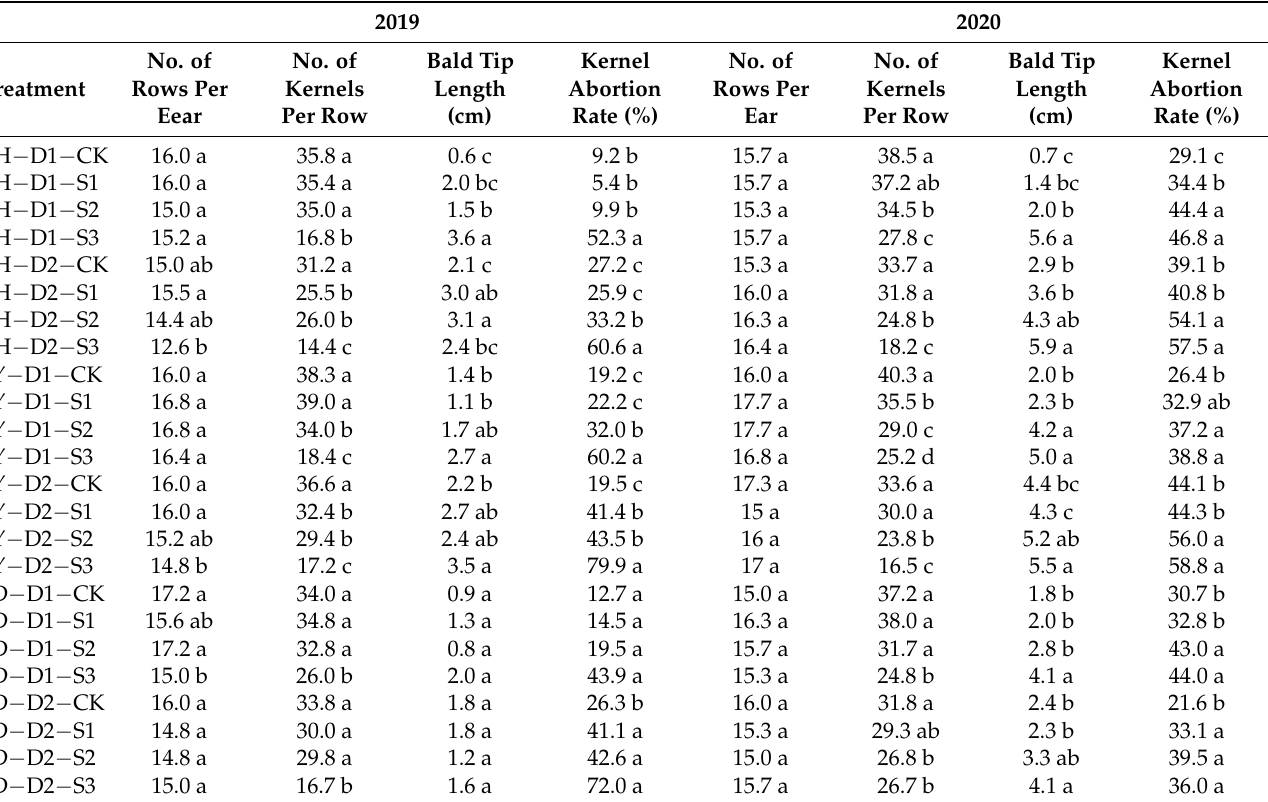
Table 2. Row numbers per ear, kernel numbers per row, lengths of bald tips, and kernel abortion rates of three maize cultivars grown at different densities and under different shading levels. See Table 1 for treatment definitions. Means with different lowercase letters are significantly different at p <